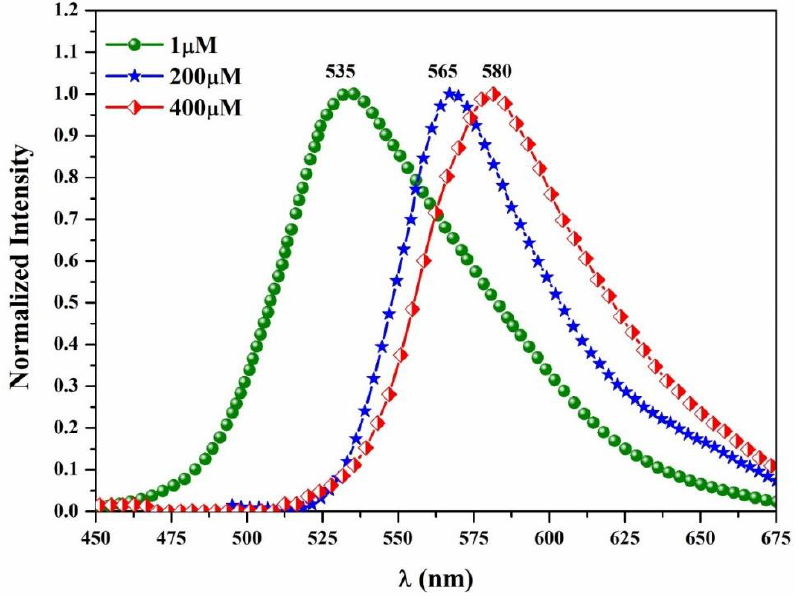
Figure 5. The fluorescence spectra of B-co-MP in THF measured for different concentrations pre-irradiation.